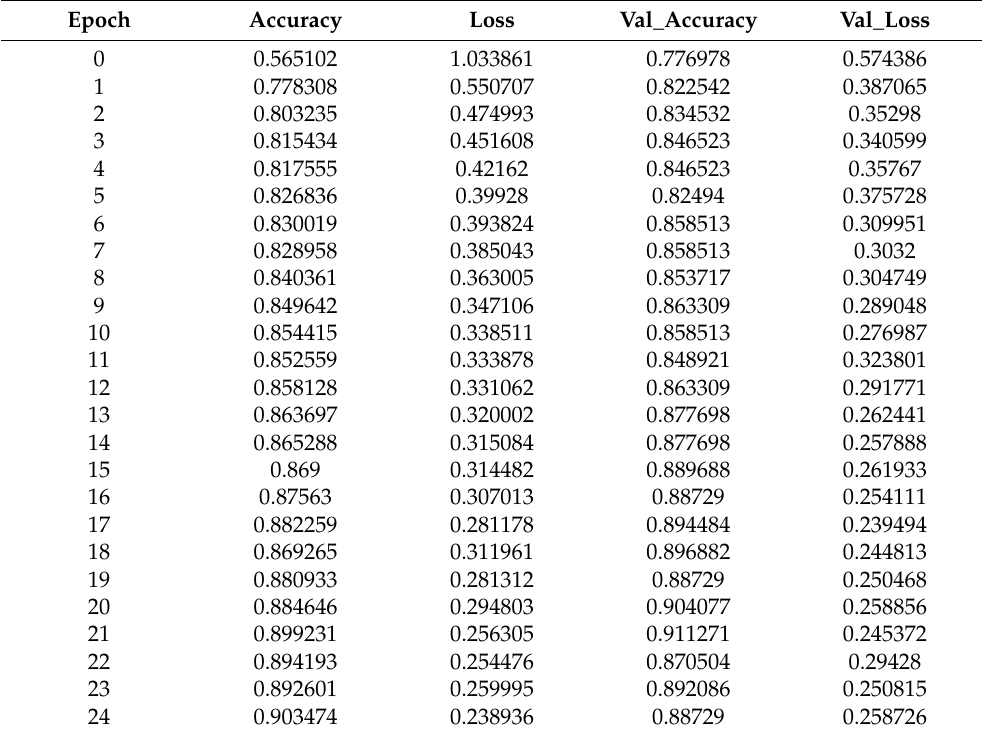
Table 4. Overall evaluation of the proposed model.